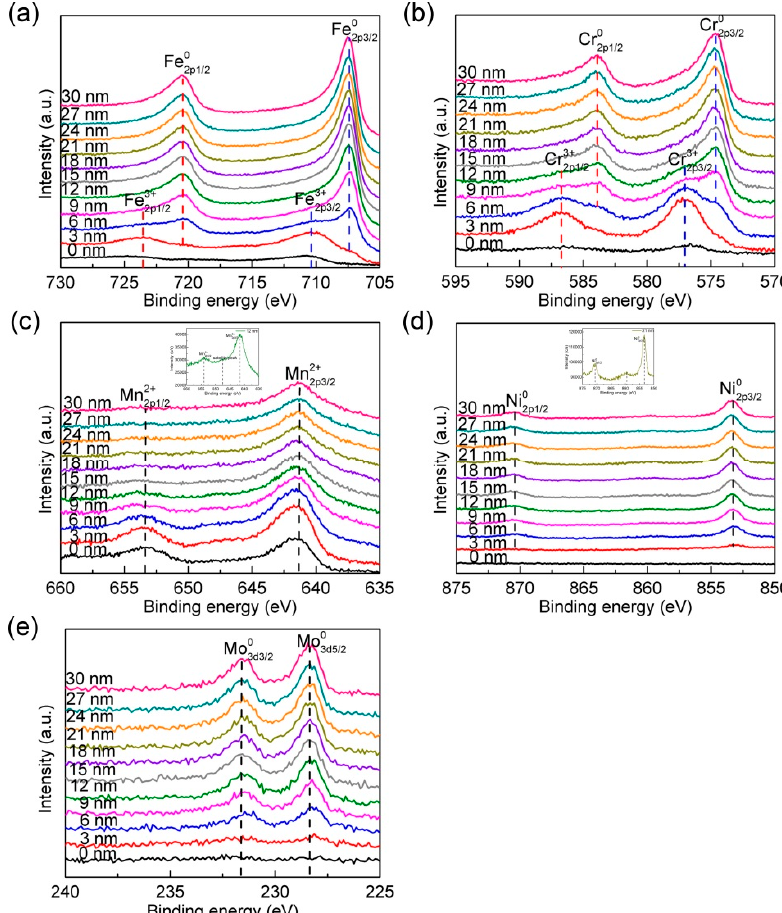
Figure 5. Detailed XPS spectra of ( a ) Fe, ( b ) Cr, ( c ) Mn, ( d ) Ni and ( e ) Mo on the surface of 316L powders in the as-received state and after ion etching up to 30 nm.